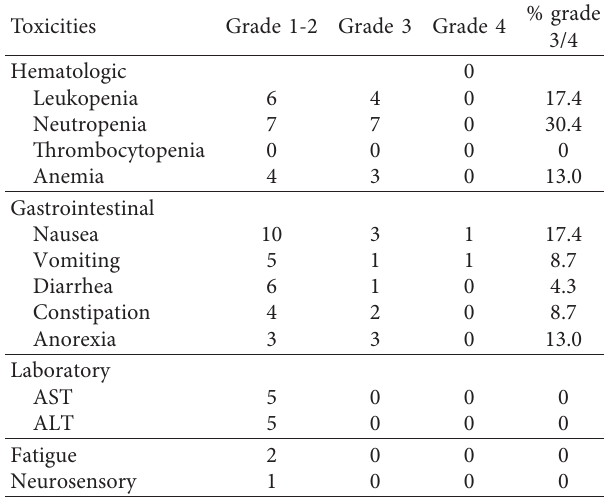
Table 2: Adverse events during neoadjuvant chemotherapy ( n �